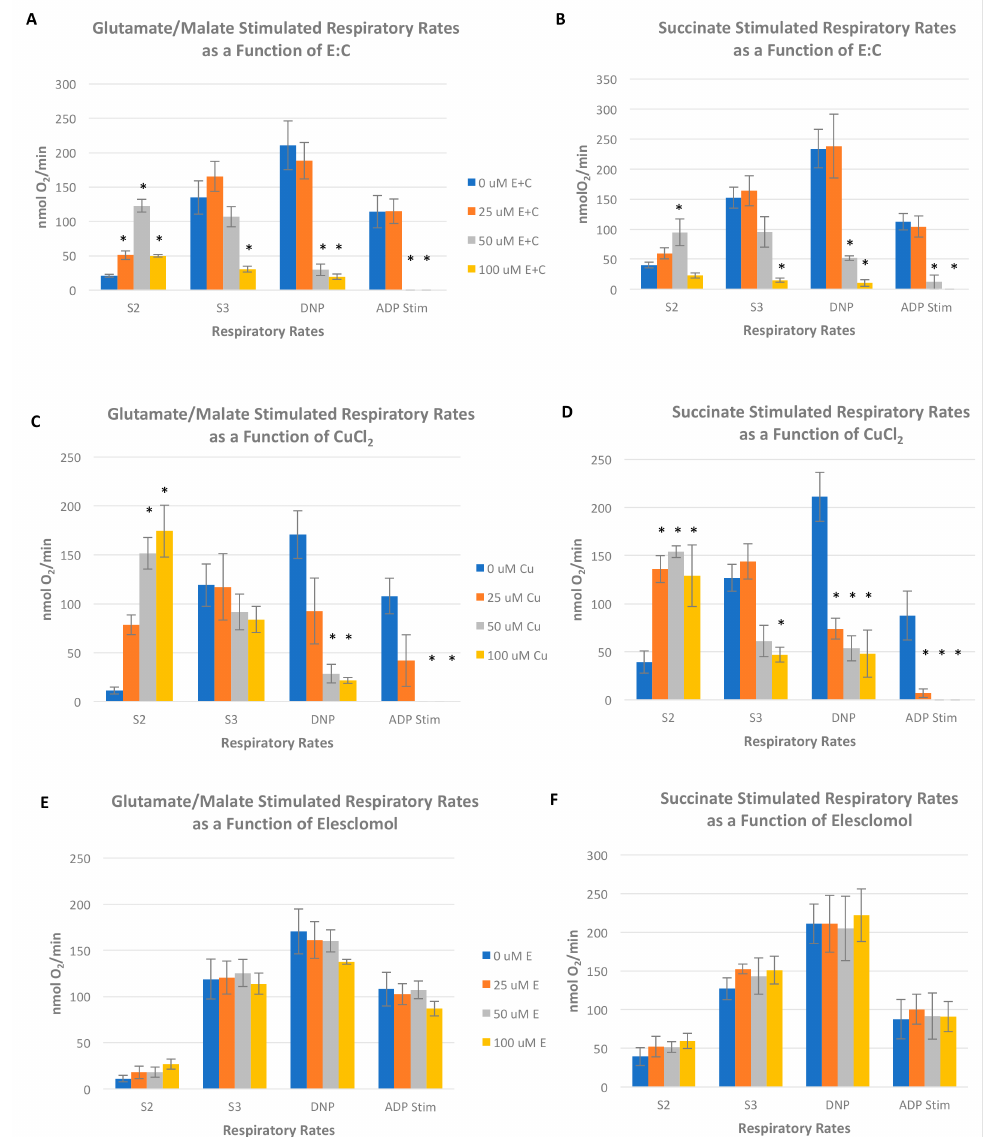
Figure 6. Polarographic measurement of oxygen consumption. Measurements of respiratory rates in intact, isolated rat liver mitochondria were made in the absence or presence of: varying concentrations of the E:C chelate with either ( A ) glutamate / malate or ( B ) succinate as the respiratory substrate; varying concentrations of CuCl 2 as a single agent with either ( C ) glutamate / malate or ( D ) succinate as the respiratory substrate; or varying concentrations of elesclomol as a single agent with either ( E ) glutamate / malate or ( F ) succinate as the respiratory substrate. Data are expressed as mean values ± SE for at least three independent experiments. A one-way ANOVA was performed followed by a Tukey’s multiple comparison test using GraphPad Prism software; * p < 0.05 vs